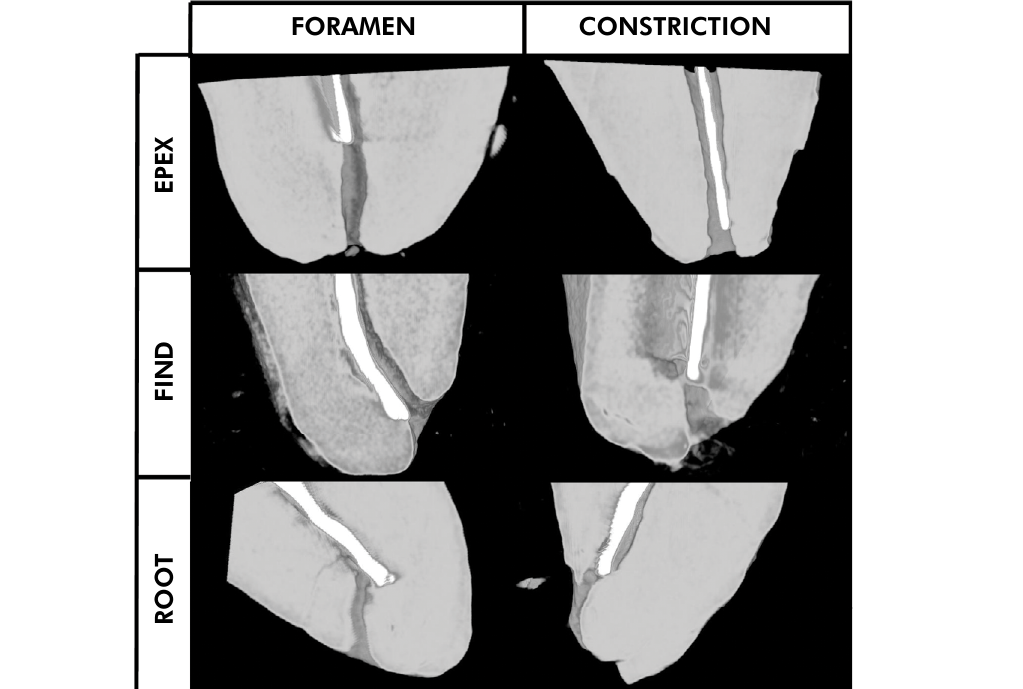
Figure 2. Representative images of the distance between the tip of the file and the constriction in Foramen group and Constriction group (9 μm, magnification of